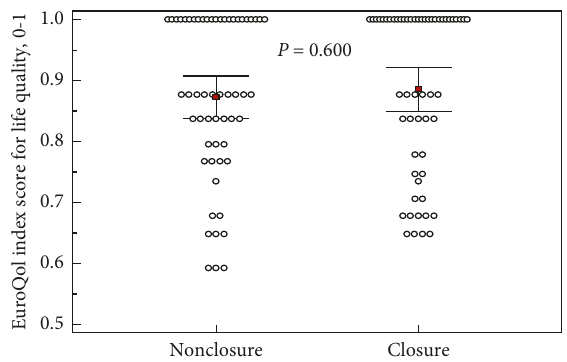
Figure 3: EuroQol-5D5L index scores for life quality assessment. EuroQol-5D-5L index scores for life quality assessment at post- operative day 10 are also shown. The greater value indicates better health status. Each group includes 56 patients. Square plots show mean values (0.87 vs. 0.89) and horizontal lines show confidence intervals (0.836–0.904 vs. 0.856–0.924) at 95% level. p value cal- culated using a Student’s t -test.